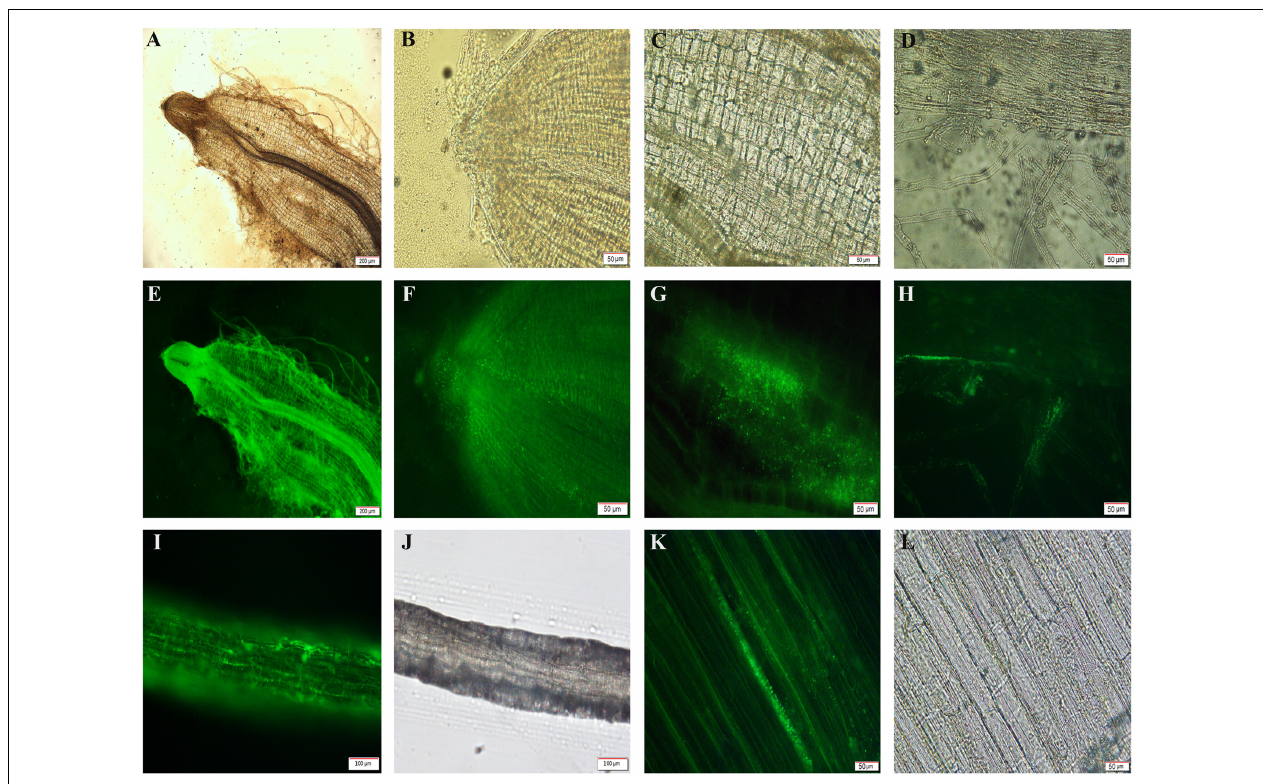
FIGURE 3 | Fluorescence micrograph of the different tissues of Chinese cabbage colonized by YL6-GFP ( A,E,B,F , root tip; C,G,D,H , root hairs; I,J , epicotyl; K,L , hypocotyl epidermis).